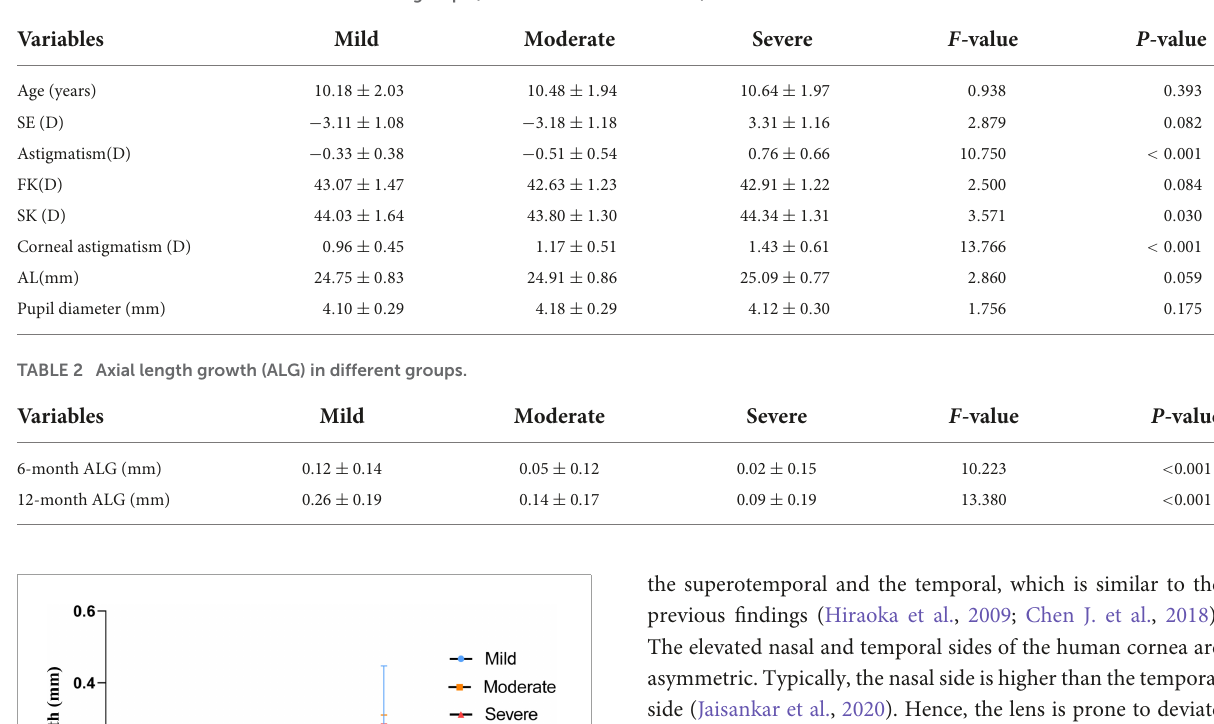
TABLE 1 Baseline data in different decentration groups (mean ± standard deviation).